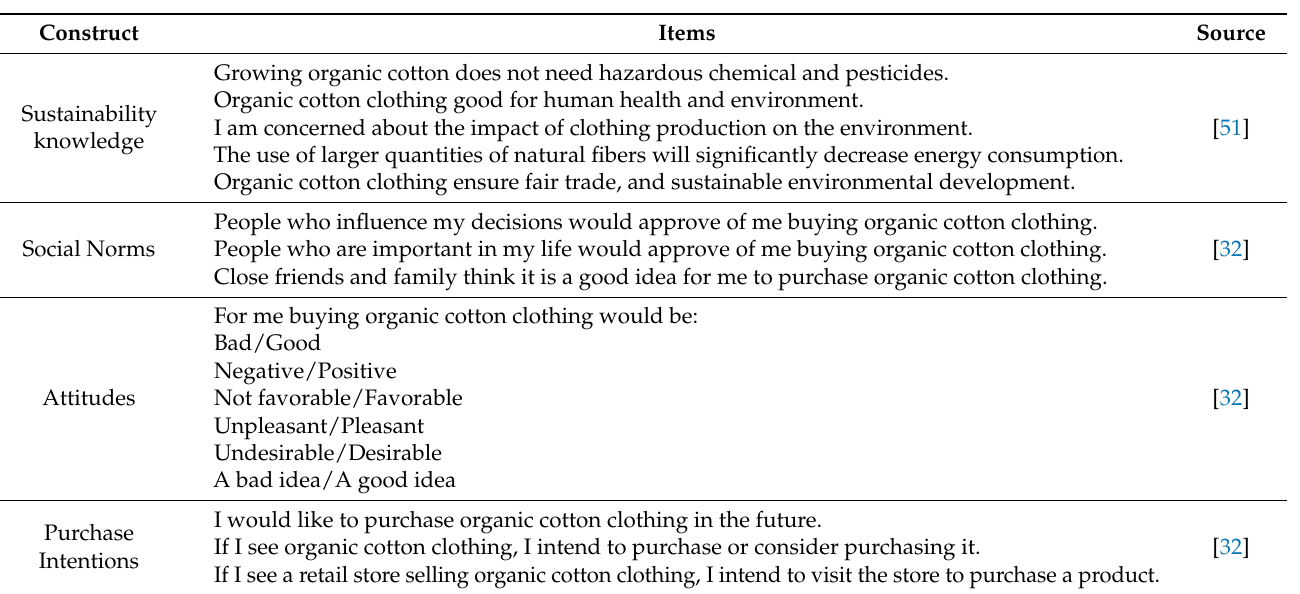
Table A1. Research item and